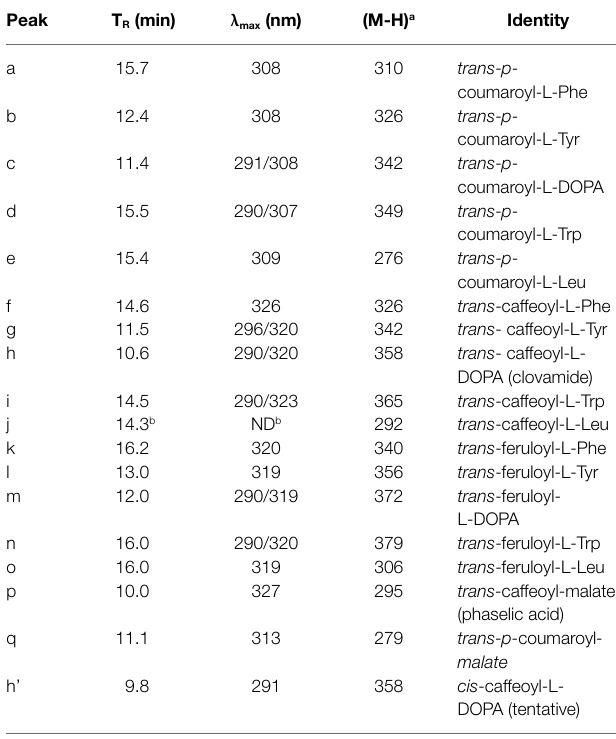
TABLE 6 | Peak characteristics and identities from Figure 4 .